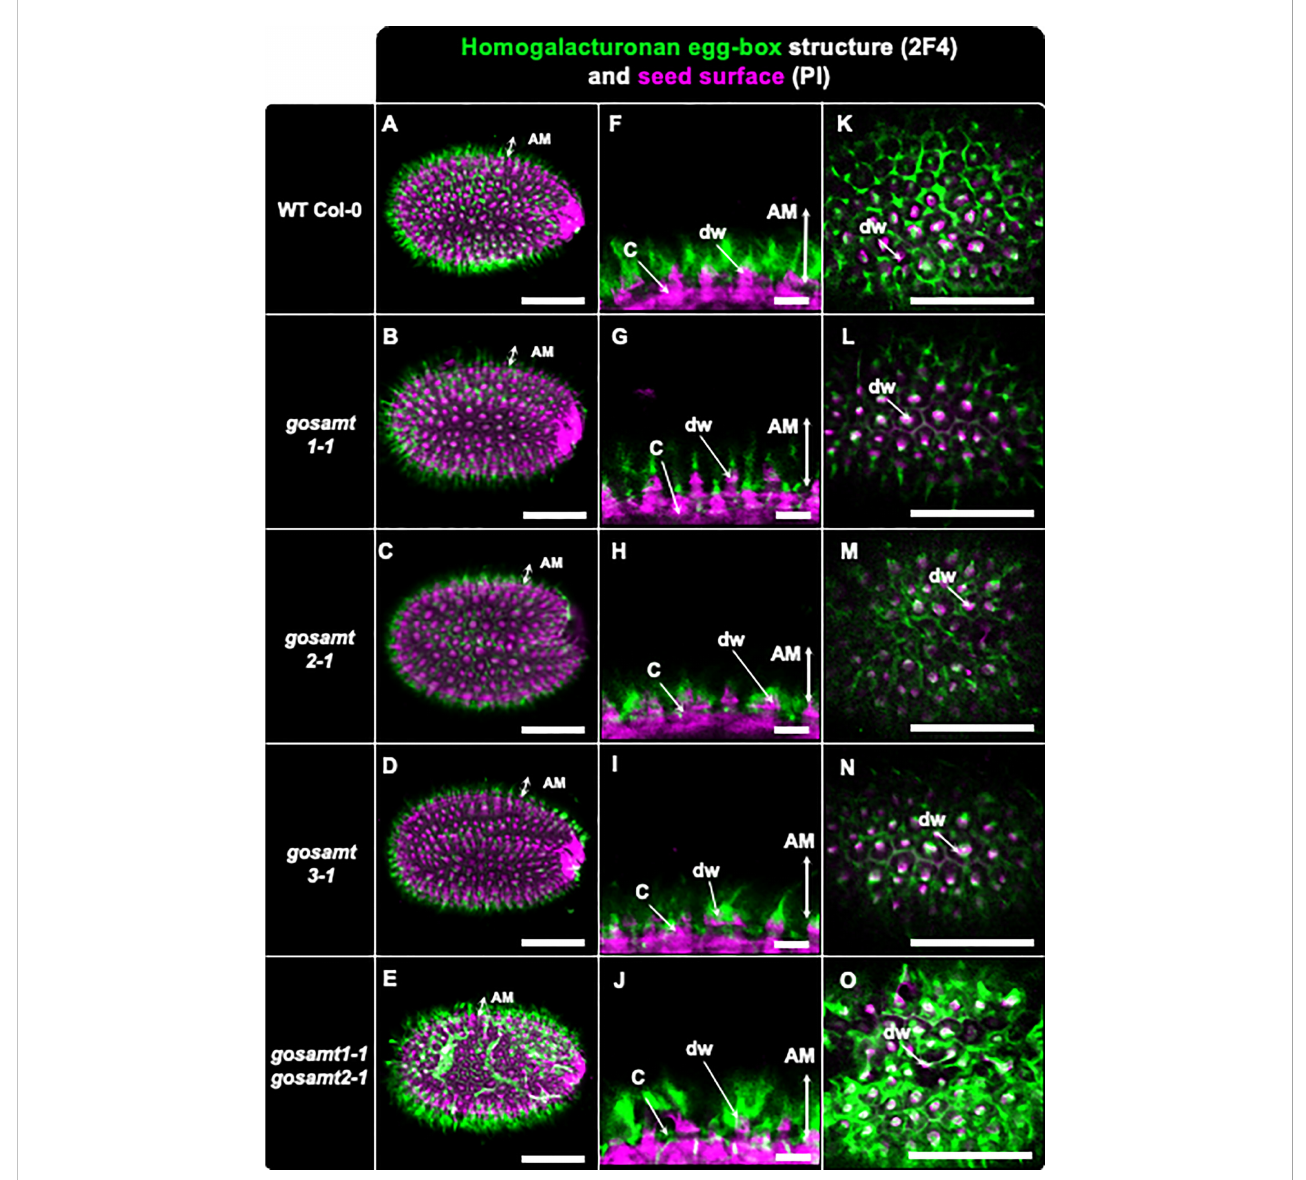
FIGURE 7 Distribution of egg-box structure recognized by 2F4 antibody in adherent mucilage layer of wild-type and gosamts mutants. Confocal microscopy images of AM released from WT Col-0 and gosamts mutant mature imbibed seeds. Fluorescence corresponds to the 2F4 antibody labelling in green, and propidium iodide, used to detect the seed Surface, in magenta. (A – E) Different optical planes showing entire seed. (F – J) Close-up of columella. (K – O) Top view of seed surface. C = columella; dw = distal cell wall; vertical arrow highlights labelled AM adherent mucilage. Scale bars: (A – E) and (K – O) = 200 µm; (F – J) = 50 m